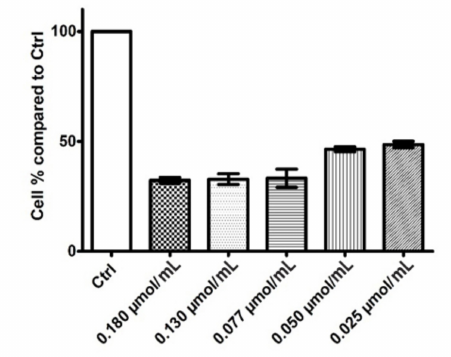
Figure 4. Inhibitory effect of rhodoxanthin at five different concentrations (C1–C5) on B16F10 murine melanoma cells. Ctrl—untreated cells. Values represent the mean ± SD of three determinations. p <